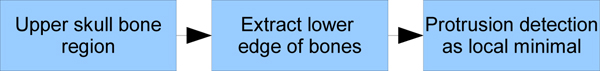
Diagram of protrusion detection. The interior edge of the skull is extracted based on the intensity. Then by viewing the extracted edge as a function curve versus the horizontal coordinate of the image, the protrusion is the local minimal point of the function curve.